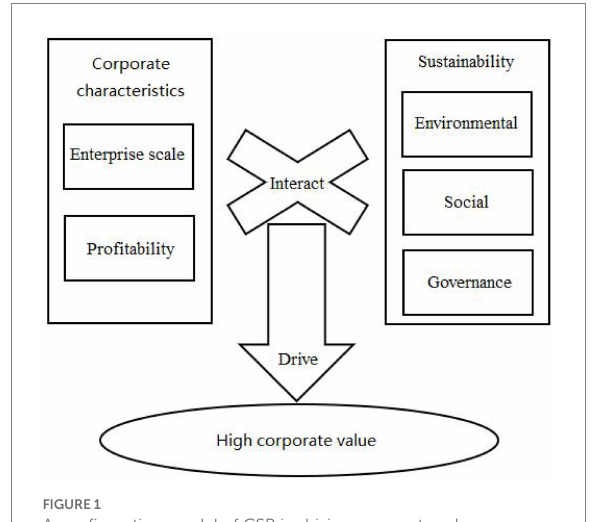
FIGURE 1 A configuration model of CSR in driving corporate value.